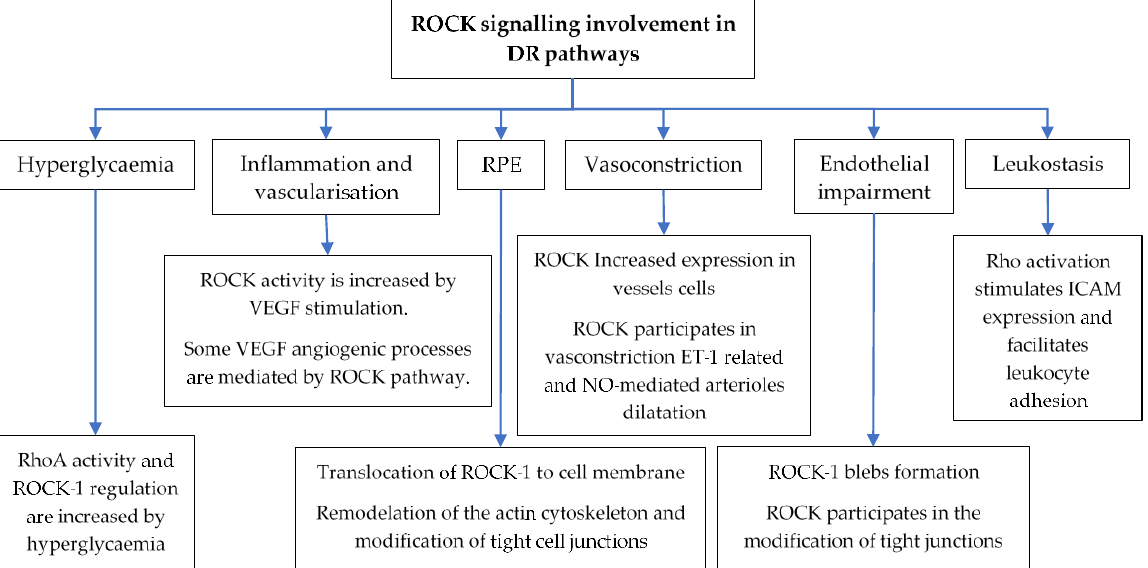
Figure 3. ROCKs involvement in the mechanisms underlying DMO according to the results of preclinical studies. Together with inflammation, elevated glucose, which is a thorn in DR, constitutes a strong stimulus for Rho pathways activation and ROCK-1 upregulation. Moreover, VEGF overproduction because of DR, also increases ROCK activity, particularly those pathways in charge of VEGF-mediated angiogenic processes, getting caught in a vicious circle. At RPE level, ROCK- 1 cytoplasmic proteins translocate to the cell membrane and participate in actin cytoskeleton and tight cell junctions remodulation. At a vascular level, the calibre of the retinal vessels is also regulated by ROCKs related pathways. In addition, they contribute to endothelial impairment by ROCK-1 blebs formation and tight junction modifications, as happened at RPE. Finally, these kinases stimulate ICAM expression, which facilitate leukocyte adhesion and contributes to leukostasis. Thus, ROCKs take part in leukostasis, inflammation and vascularisation processes and participate in endothelial and RPE impairment, perpetuating DMO pathogenesis.